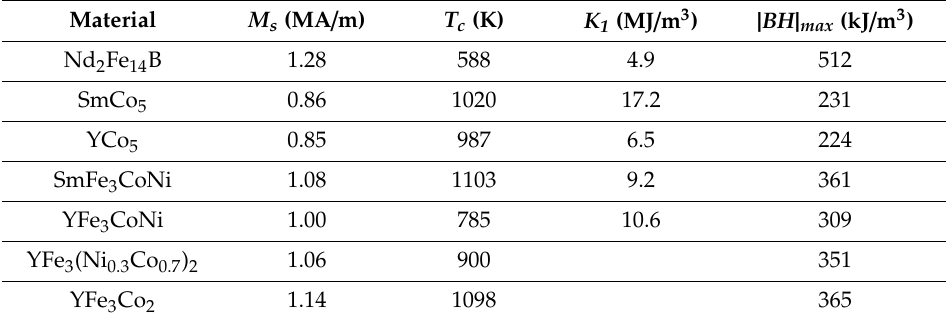
Table 5. Intrinsic magnetic properties of Nd 2 Fe 14 B, SmCo 5 , and YCo 5 (experiment [6,7,10,11]); and SmFe 3 CoNi [3,4], YFe 3 CoNi, (K 1 , LDA), YFe 3 (Ni 0.3 Co 0.7 ) 2 , and YFe 3 Co 2 (theory) permanent